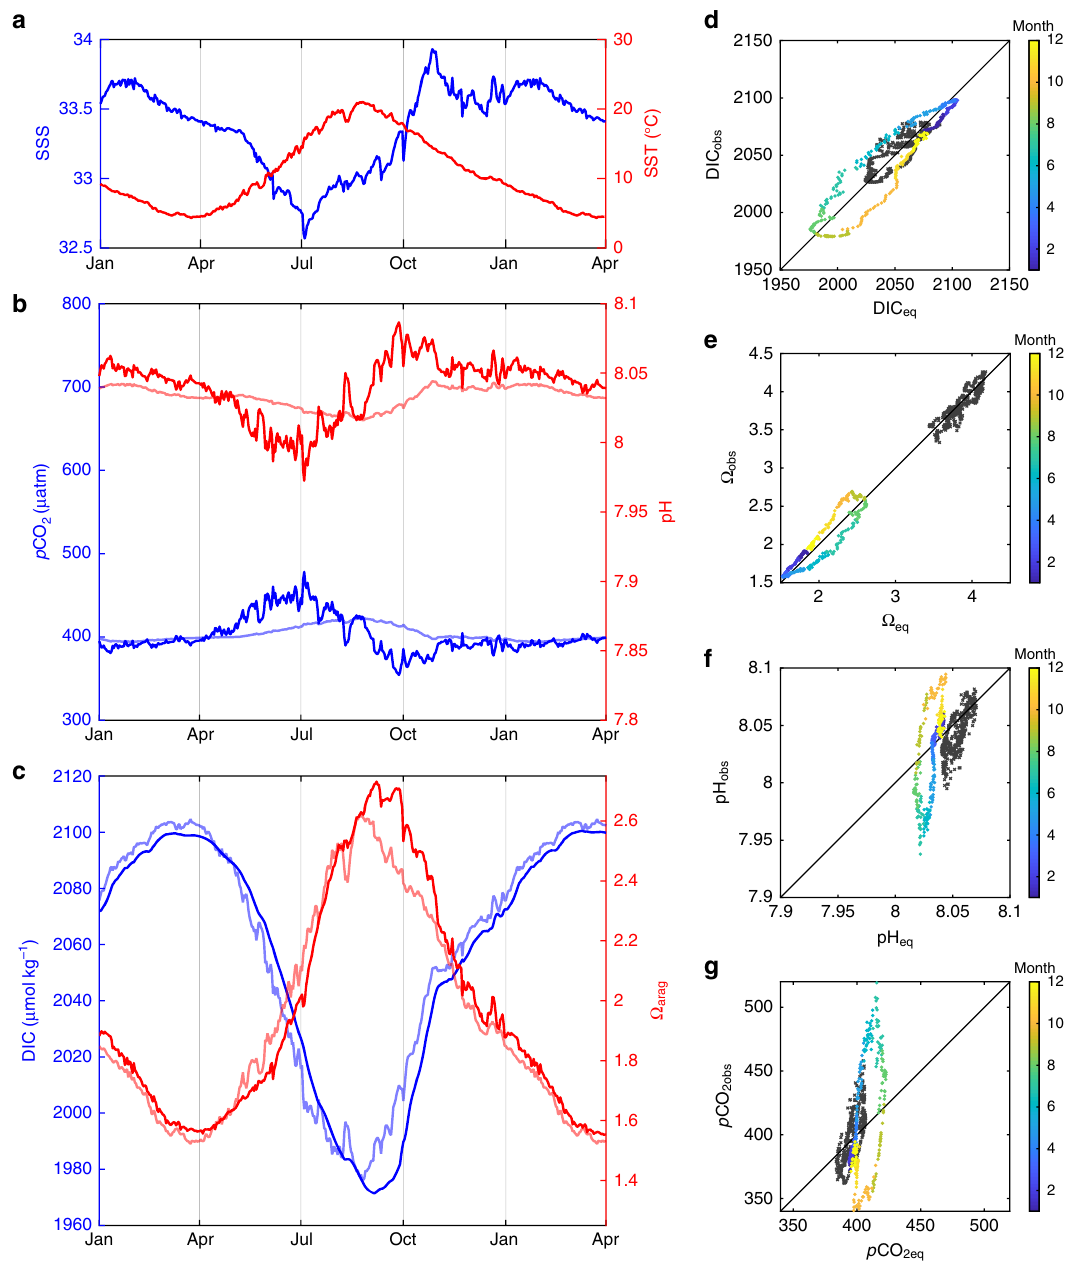
Fig. 6 Simulations of p CO 2 , pH, DIC, and Ω arag . Simulations were run using a box model and values derived from the assumption of instantaneous CO 2 equilibrium with the atmosphere. In the left column are a prescribed SST and SSS, b model-generated p CO 2 and pH, and c model-generated DIC and Ω arag for Gulf of Maine waters. Heavy lines are box-model simulations and light lines are calculated values from instantaneous equilibrium with the atmosphere. For simplicity, we assume atmospheric p CO 2 is seasonally invariant. In the right column, model observed d p CO 2 , e pH, f DIC, and g Ω arag are plotted against those predicted from equilibration with the atmosphere (eq), similar to those in Fig. 5. Symbols color coded by month represent the Gulf of Maine simulation (with colder temperature), and black symbols represent the South Atlantic Bight simulation (warmer